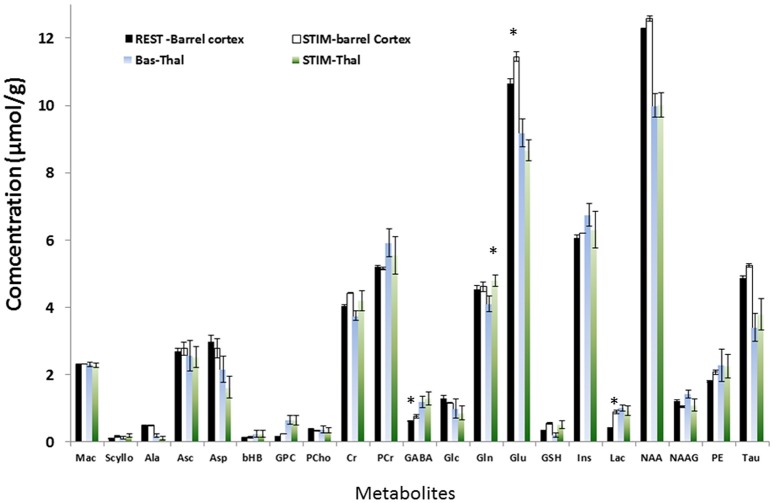
Neurochemical profile of S1BF and thalamus during rest and TGN stimulation for 21 metabolites. In S1BF, Lac, Glu, GABA levels were significantly higher during stimulation (p = 0.0015, p = 0.015, and p = 0.021 respectively, one-way ANOVA and Bonferroni correction). Glc and Asp demonstrated a tendency to decrease (p > 0.05). In Thalamus, Gln was significantly higher during TGN stimulation (p < 0.009, ANOVA +Bonferroni) while Glu only showed a strong tendency to decrease. Regional differences were demonstrated between thalamus and S1BF metabolites at rest and during stimulation using a two-way ANOVA test with Bonferroni correction. Significant differences between brain structures were found for Glu (p < 0.0001), Lac (p = 0.02), and GABA (p = 0.005). Changes in [Glu] and [GABA] in both S1BF and thalamus were significantly related to changes related to activation (p = 0.02).